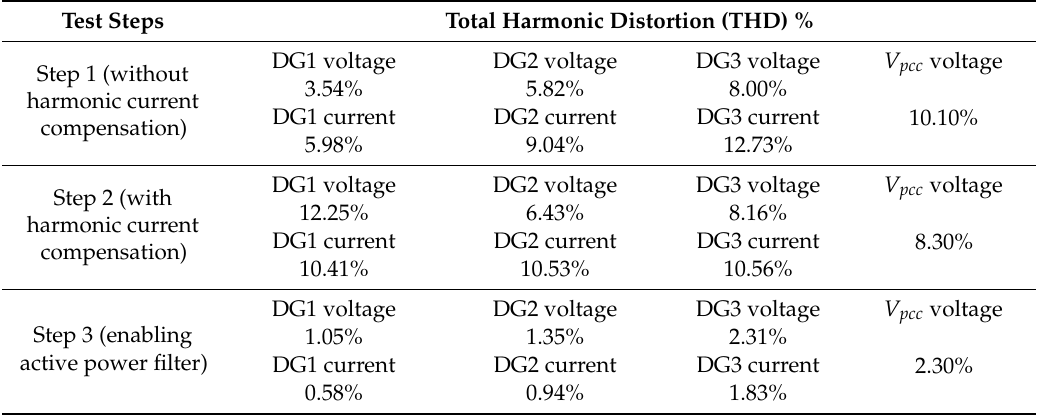
Table 3. Output DG voltages and V pcc THDs under di ff erent